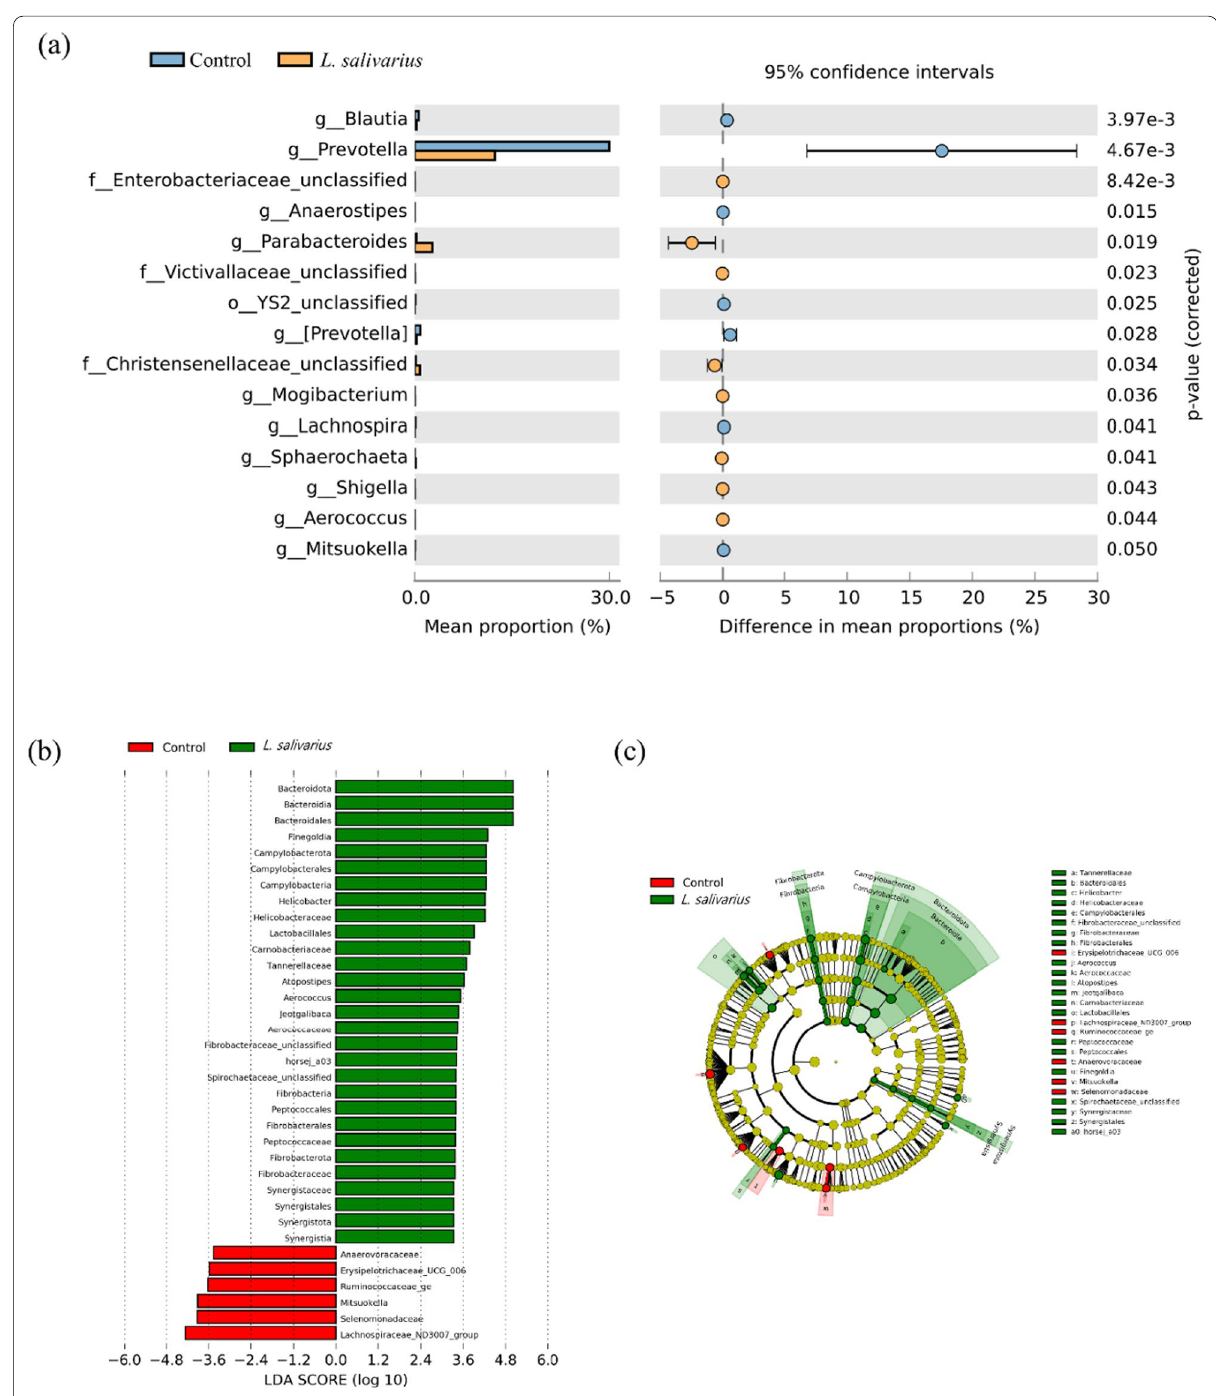
Fig. 3 The relative abundance of bacterial community composition. Comparison of the gut microbiota between the control group and the L. salivarius group at the genus level with significantly different abundances ( a ). Taxonomic feature identification between the control and heat-killed L. salivarius groups using linear discriminant analysis effect size (LEfSe) analyses: a histogram and b cladogram. Significance was present at p < 0.05 for the LEfSe analyses for both the Kruskal–Wallis and Wilcoxon tests, and the minimum linear discriminant analysis (LDA) score was set to